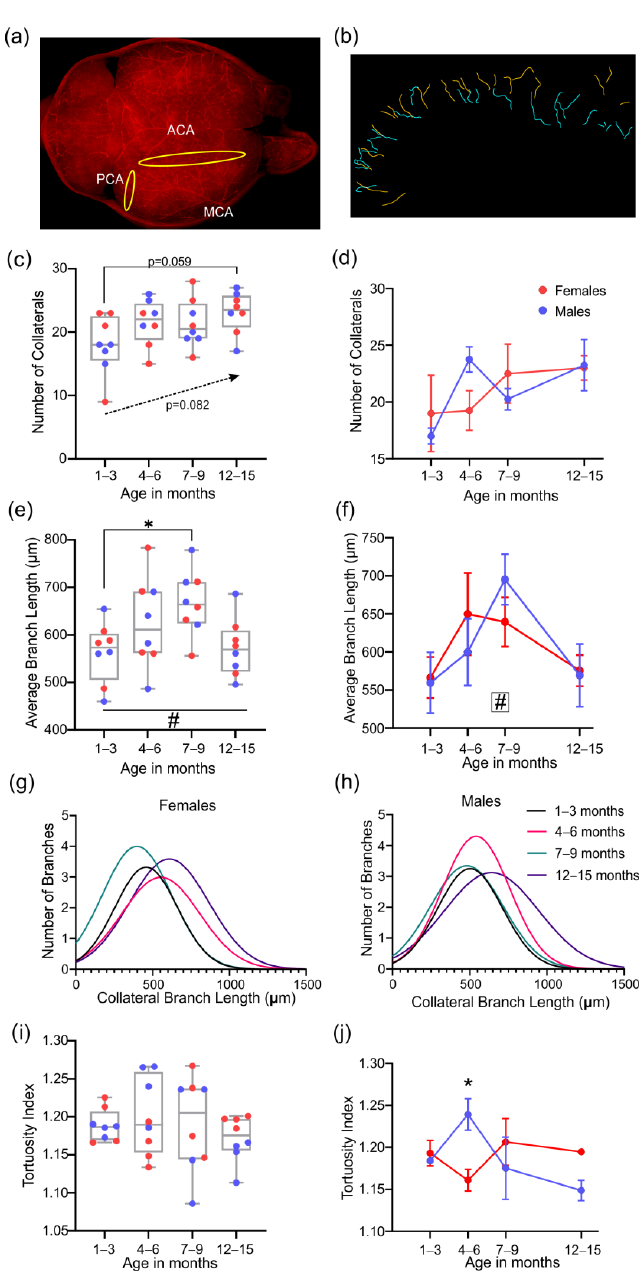
Figure 8. Collateral vessels between MCA and ACA/PCA. ( a ) Representative images illustrating the location of the collaterals and the region of anastomosis. ( b ) The collateral skeletons are shown for a male (cyan) and female (orange) mouse at 4 – 6 months. ( c ) The number of collaterals across all age groups showed a trending increase ( p = 0.082) with age that was maximal at 12 – 15 months. ( d ) No overt differ- ences were found based on sex. With an increased number of collaterals, there was an increased average collateral branch length ( e ), which was not different across sexes ( f ). Distribution of the collateral branch length reveals differences between females ( g ) and males ( h ) at different ages. The average tortuosity index of the collateral branches across age groups was not significantly different ( i ), but males showed